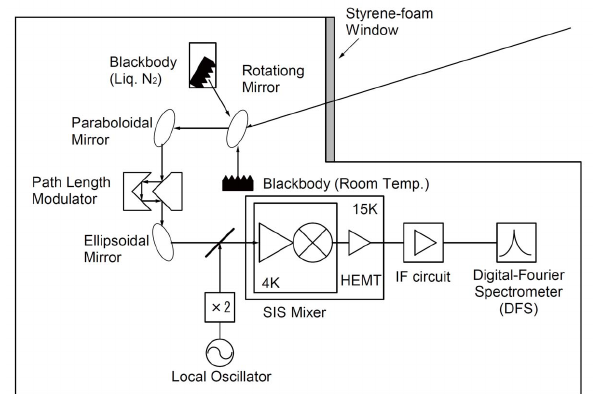
Fig. 1. Block diagram of the millimeter-wave spectroscopic ra- diometer in Atacama,